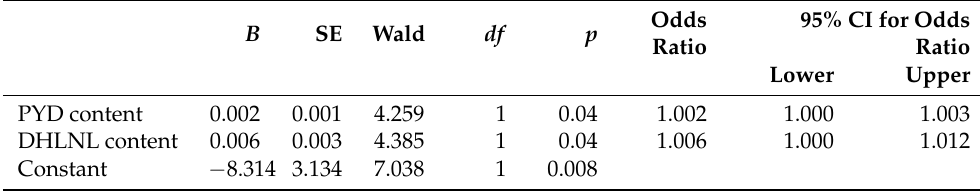
Table 5. Results of the logistic regression test for predicting humeral fracture in cows based on PYD: pyridinoline and DHLNL: dihydroxylysinonorleucine content in bone; B: B coefficient for the constant; SE: standard error; Wald: Wald chi-square test; df : degrees of freedom; CI: confidence